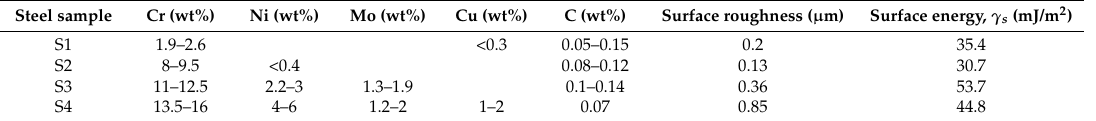
Table 1. Stainless steel substrates nominal compositions and surface